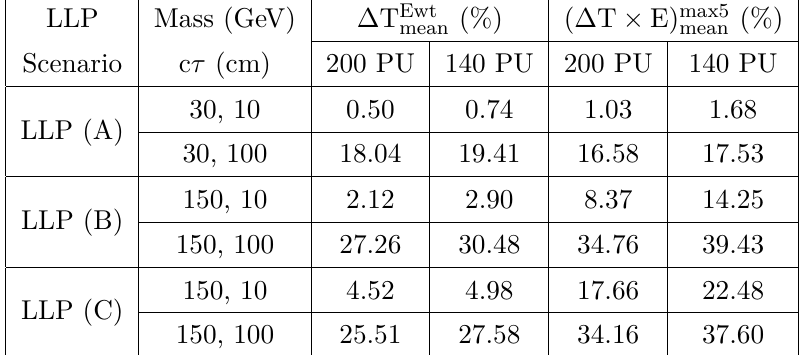
Table 5 . Trigger efficiency for three benchmark masses from the three LLP scenarios with cτ = 10 cm and 100 cm calculated by putting suitable thresholds on the two timing variables to keep the background rate restricted at ≈ 30 kHz when the ECAL timing resolution corresponding to 1000 fb − 1 luminosity is applied in the 200 PU scenario. For comparison, we have quoted the corresponding signal efficiencies for the 140 PU scenario with the same timing resolution and same constraint on the background